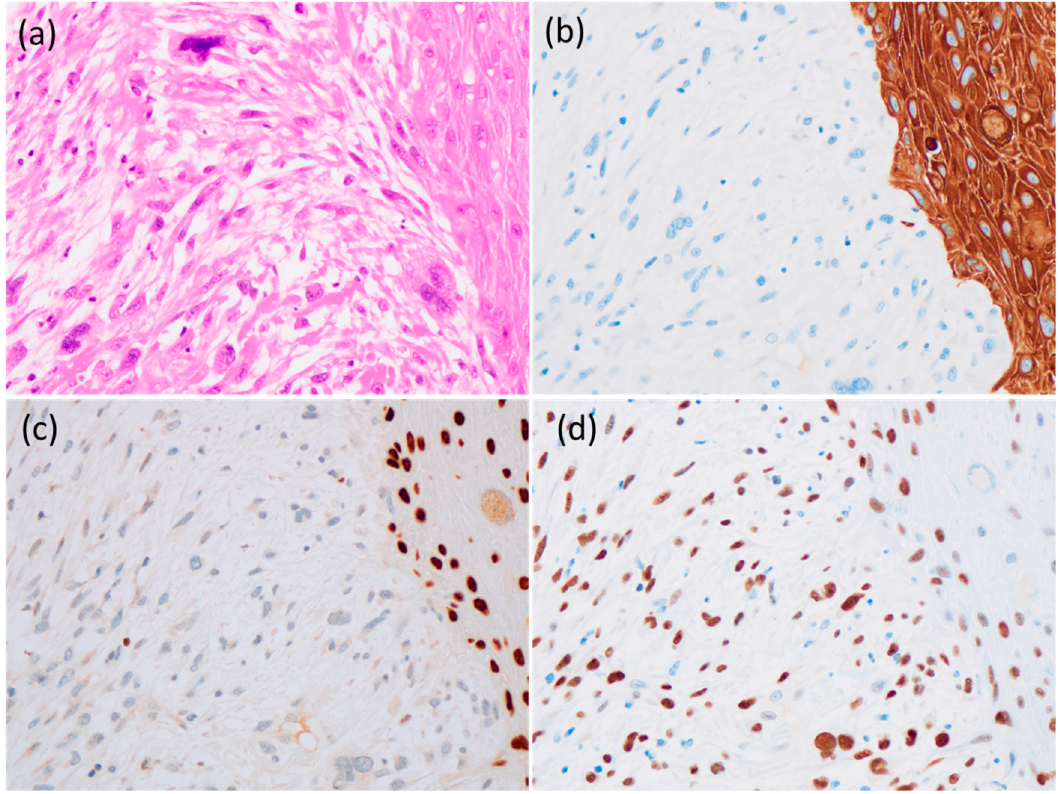
Figure 5. Histological and immunohistochemical finding of the tumor. ( a ) The spindle cells with nuclear pleomorphism had continuity with atypical epithelial cells (400×). ( b ) The spindle cells were negative for cytokeratin AE1/AE3 (400×), but atypical epithelial cells were positive. ( c ) The spindle cells were negative for p63 (400×), but atypical epithelial cells were positive. ( d ) Both the spindle and atypical epithelial cells were positive for p53 (400×).